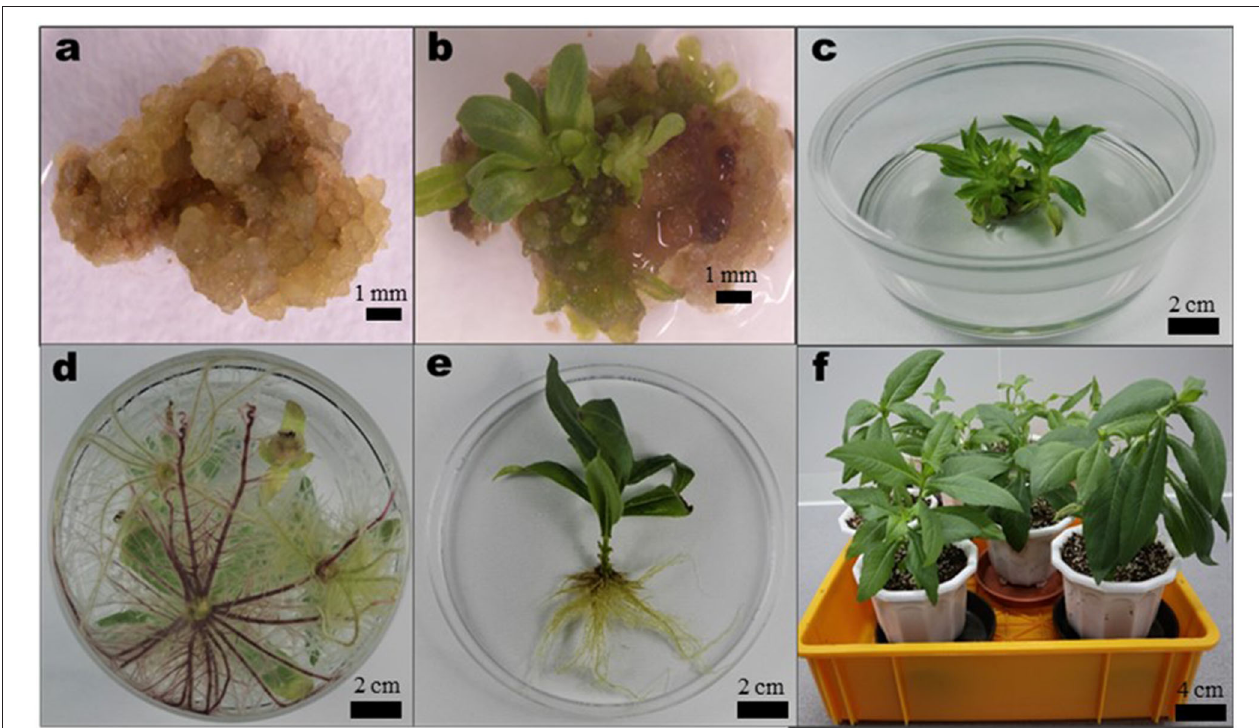
FIGURE 2 | Summary of in vitro propagation of A. africana from callus. (a) Newly formed callus placed in the Murashige and Skoog (MS) medium supplemented with 1.0 mg/L BAP, 0.5 mg/L Thidiazuron (TDZ), and 0.05 mg/L 1-Naphthaleneacetic acid (NAA), (b) Shoot organogenesis occurring on callus after 7 weeks in regeneration medium, (c) developed shoots from callus, (d) rooting of in vitro regenerated shoots in 1/2MS medium supplemented with 0.1 mg/L NAA, (e) fully developed plantlet removed from medium and roots washed, and (f) acclimatized potted